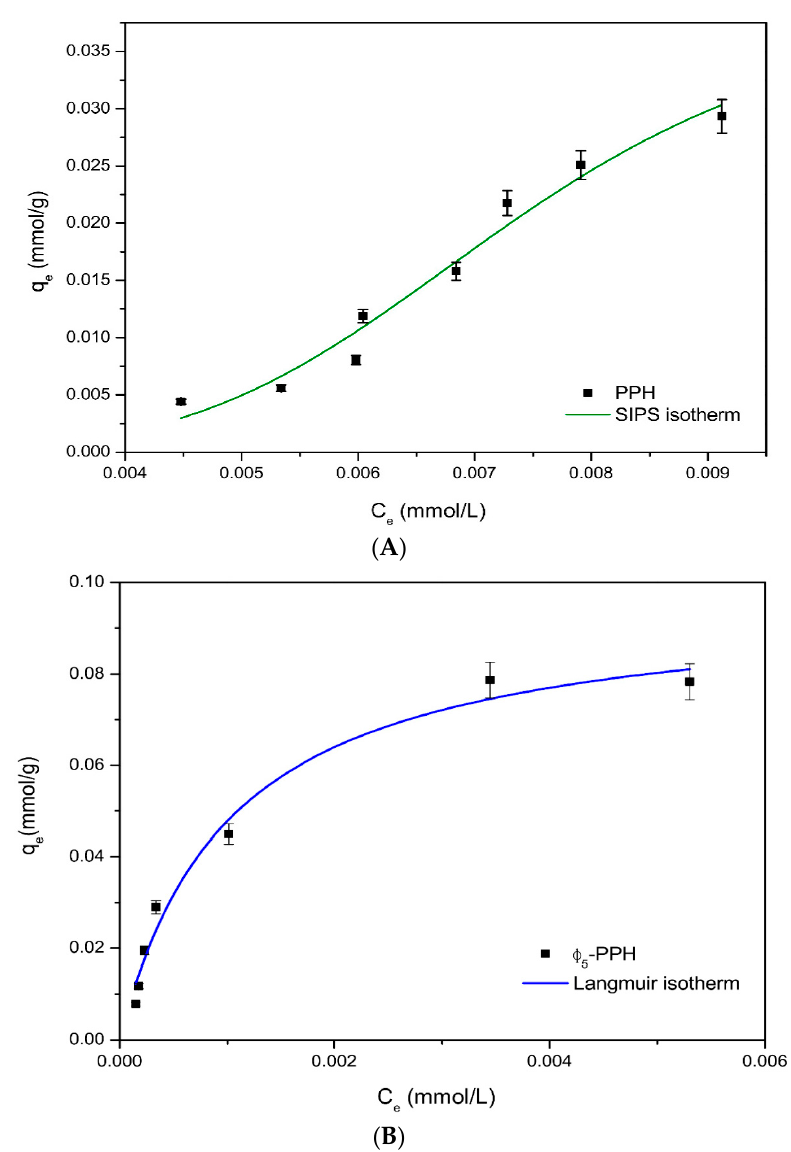
Figure 3. AB113 adsorption isotherms in ( A ) PPH and ( B ) Φ 5 -PPH and in relation to mmol AB113 for g of sorbent.